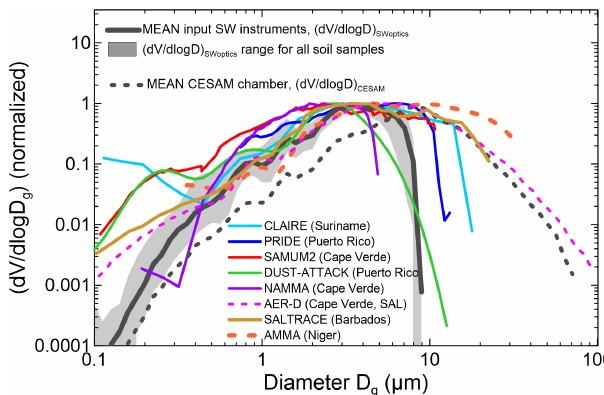
Figure 4. Comparison of dust size distributions sensed by the SW optical instruments (i.e., behind the SW instrument inlet ( d V/ dlog D g ) SWoptics ), with field data for long-range- transported dust. The thick black line represents the mean value of ( d V/ dlog D g ) SWoptics at the peak of the dust injection in CESAM for experiments with the different samples. The grey shaded area indicates the range of ( d V/ dlog D g ) SWoptics for all samples. The dotted black line shows the average of the dust size distribution at the peak of the injection inside the CESAM chamber from DB17. Field data are from the following: Formenti et al. (2001) (CLAIRE campaign in Suriname, South America), Maring et al. (2003), and Denjean et al. (2016b) (PRIDE and DUST-ATTACK campaigns in Puerto Rico, Caraibes); Müller et al. (2011), Chen et al. (2011), and Ryder et al. (2018) (SAMUM2, NAMMA, and AER-D cam- paigns in Cape Verde, eastern Atlantic); and Weinzierl et al. (2017) (SALTRACE campaign, data from Barbados). For comparison, data taken close to the source in Niger from Formenti et al. (2011) dur- ing the AMMA campaign are also shown. SAL stands for Saharan Air Layer. All data are reported as volume size distributions nor- malized at the maximum. The different acronyms are spelled